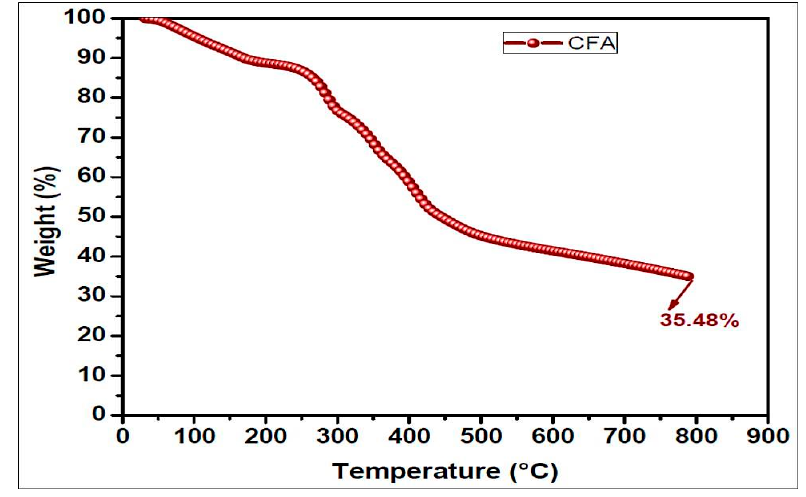
Figure 7. TGA curve of the CFA (ETPMP). Table 2. TGA results of the